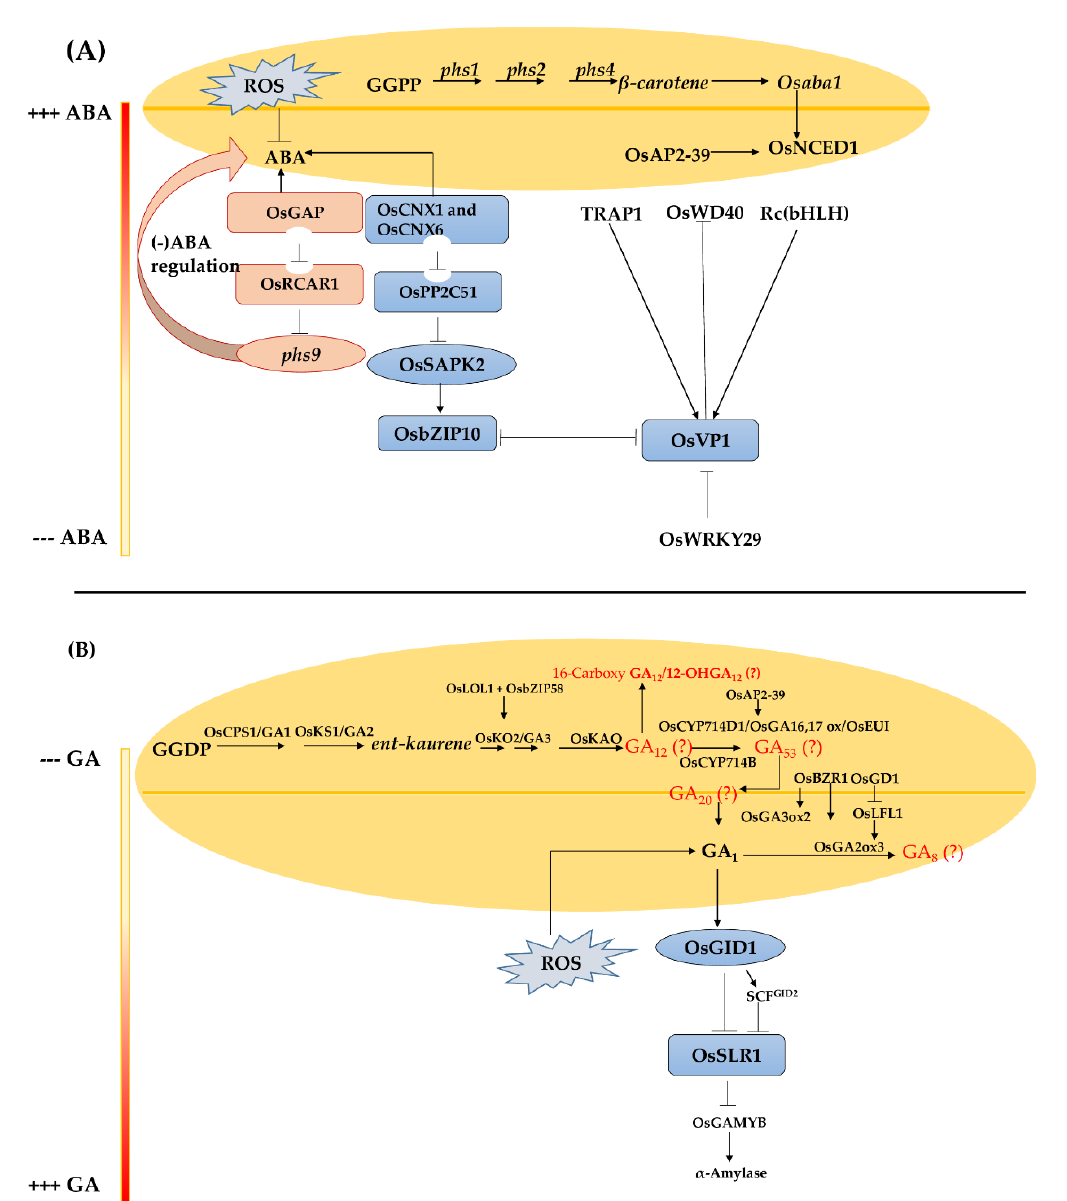
Figure 3. Regulatory networks of abscisic acid (ABA) and gibberellic acid (GA) of pre-harvest sprouting (PHS) in rice. ( A ) High accumulation of ABA in seeds can reduce the risk of PHS advent. At an early stage of ABA biosynthesis, beta carotenoid acts as a precursor with the conversion of geranylgeranyl pyrophosphate (GGPP). ABA signaling is regulated by downstream transcription factors such as OsbZIP, OsWRKY29, Rc(bHLH), OsWD40, TRAP1, and OsAP2-39. ( B ) Regulatory networks of gibberellin (GA) regulation of PHS in rice. Increased content of GA in seeds induce PHS. At an early step of GA biosynthesis, CPS-like, KS-like, and KO-like genes convert geranylgeranyl diphosphate (GGDP) to intermediate GA. The main core of GA synthesis in rice is defined by the complex GA 1 —OsGID1-OsSLR1-OsGAMYB. The red color of GA was predicted in Arabidopsis thaliana [123] (+++ is high hormone concentration whereas — is low hormone concentration of both ABA and GA respectively).